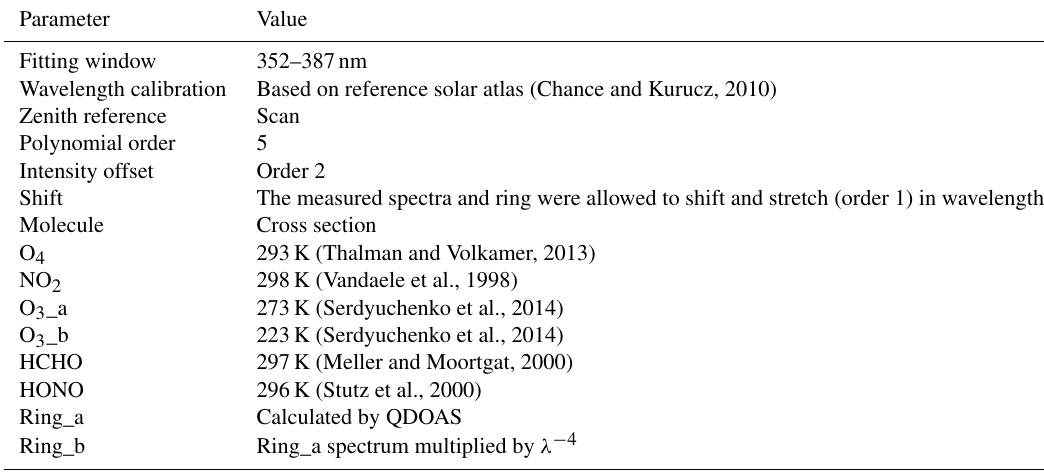
Table 2. DOAS spectral settings for the retrieval of O 4 and NO 2 in the VIS. Parameter Value Fitting window 438–487nm Wavelength calibration Based on reference solar atlas (Chance and Kurucz, 2010) Zenith reference Scan Polynomial order 5 Intensity offset Order 2 Shift The measured spectra and ring were allowed to shift and stretch (order 1) in wavelength. Molecule Cross section O 4 293K (Thalman and Volkamer, 2013) NO 2 298K (Vandaele et al., 1998) O 3 _a 273K (Serdyuchenko et al., 2014) O 3 _b 223K (Serdyuchenko et al., 2014) H 2 O 296K (Rothman et al., 2010) Glyoxal 296K (Volkamer et al., 2005) Ring_a Calculated by QDOAS Ring_b Ring_a spectrum multiplied by λ −